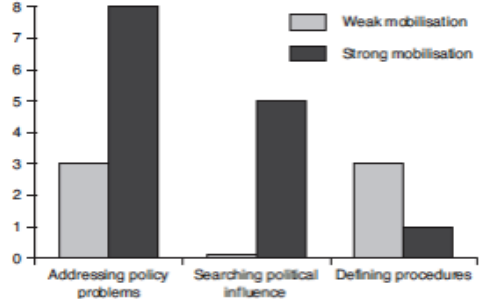
Graf. 4 - Type of theme debated in six LHCs in areas with different histories of mobilization